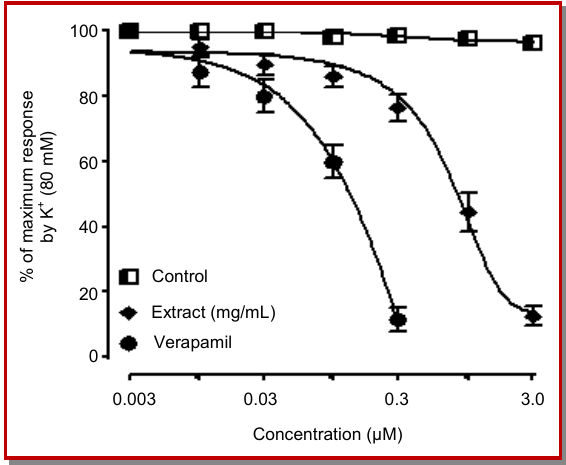
Figure 2: Bar diagram showing the effect of J. gossypifolia in comparison to the acetylcholine maximum response in rabbit jejunum preparation